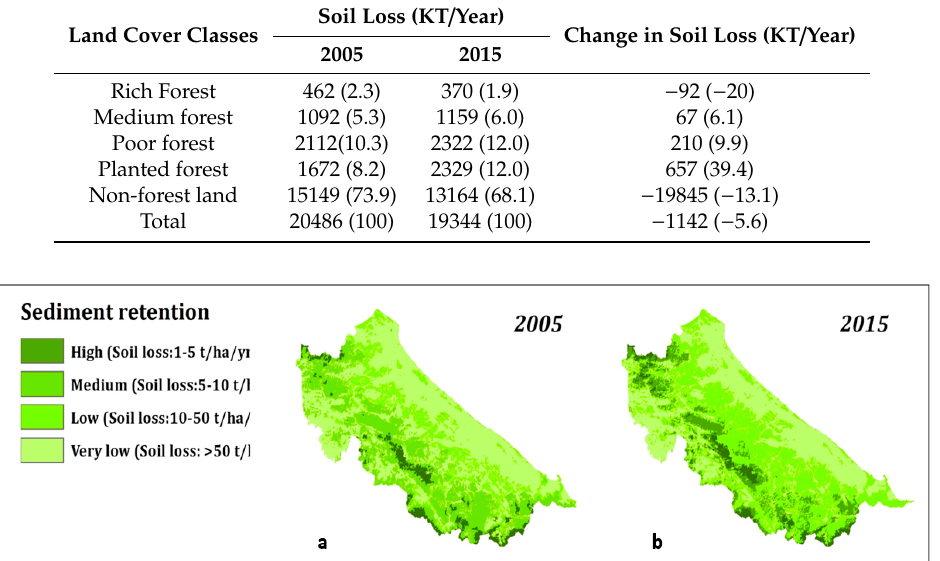
associated with the change in the area of different types of land cover. In thousands of tons per year